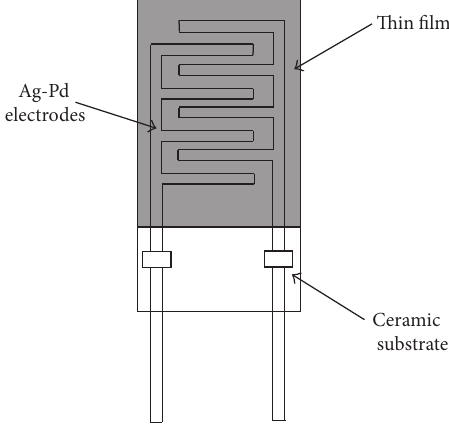
Figure 1: The schematic diagram of sensor